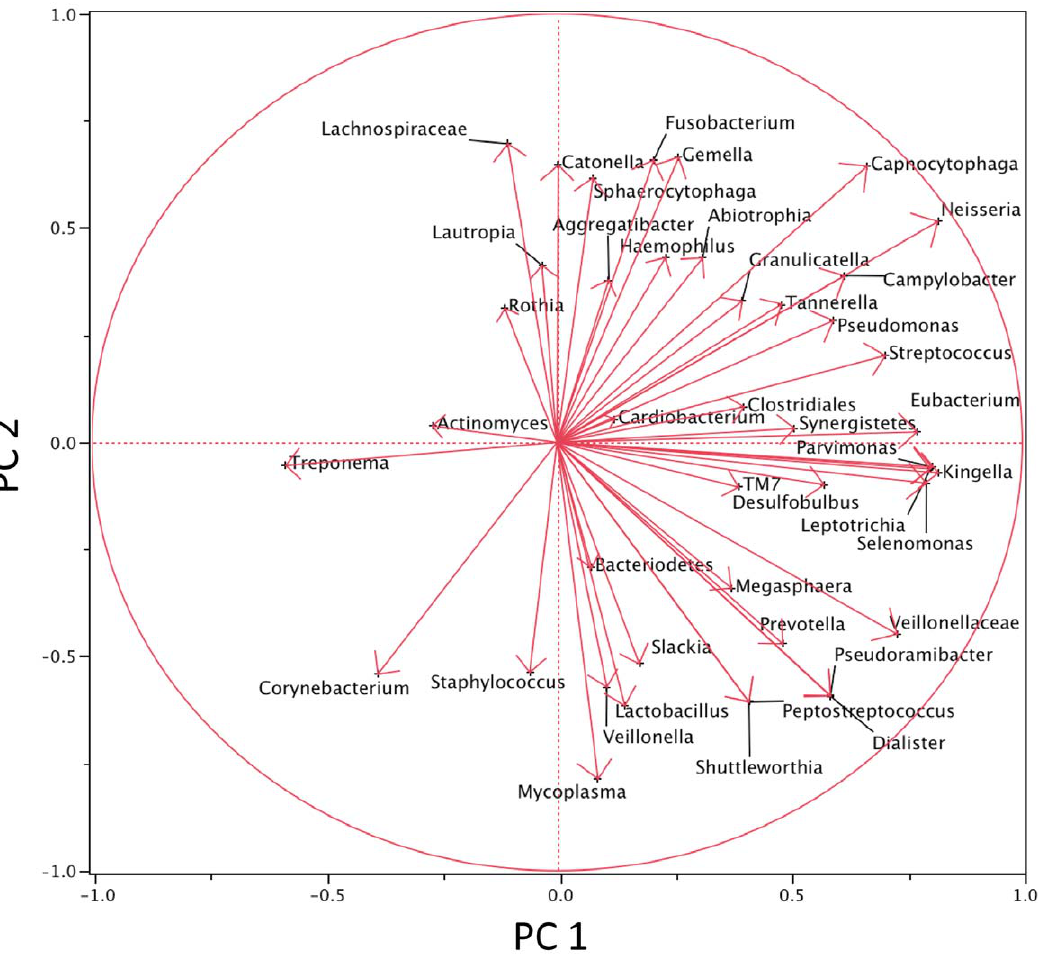
Figure 5. Genera Factor Loading of Principal Component Analysis. Factor loading plot of proportion of positive probes further illustrates the PCA plot from Figure 4. The loading of the 43 genera show how each genus contributed to the score plot.